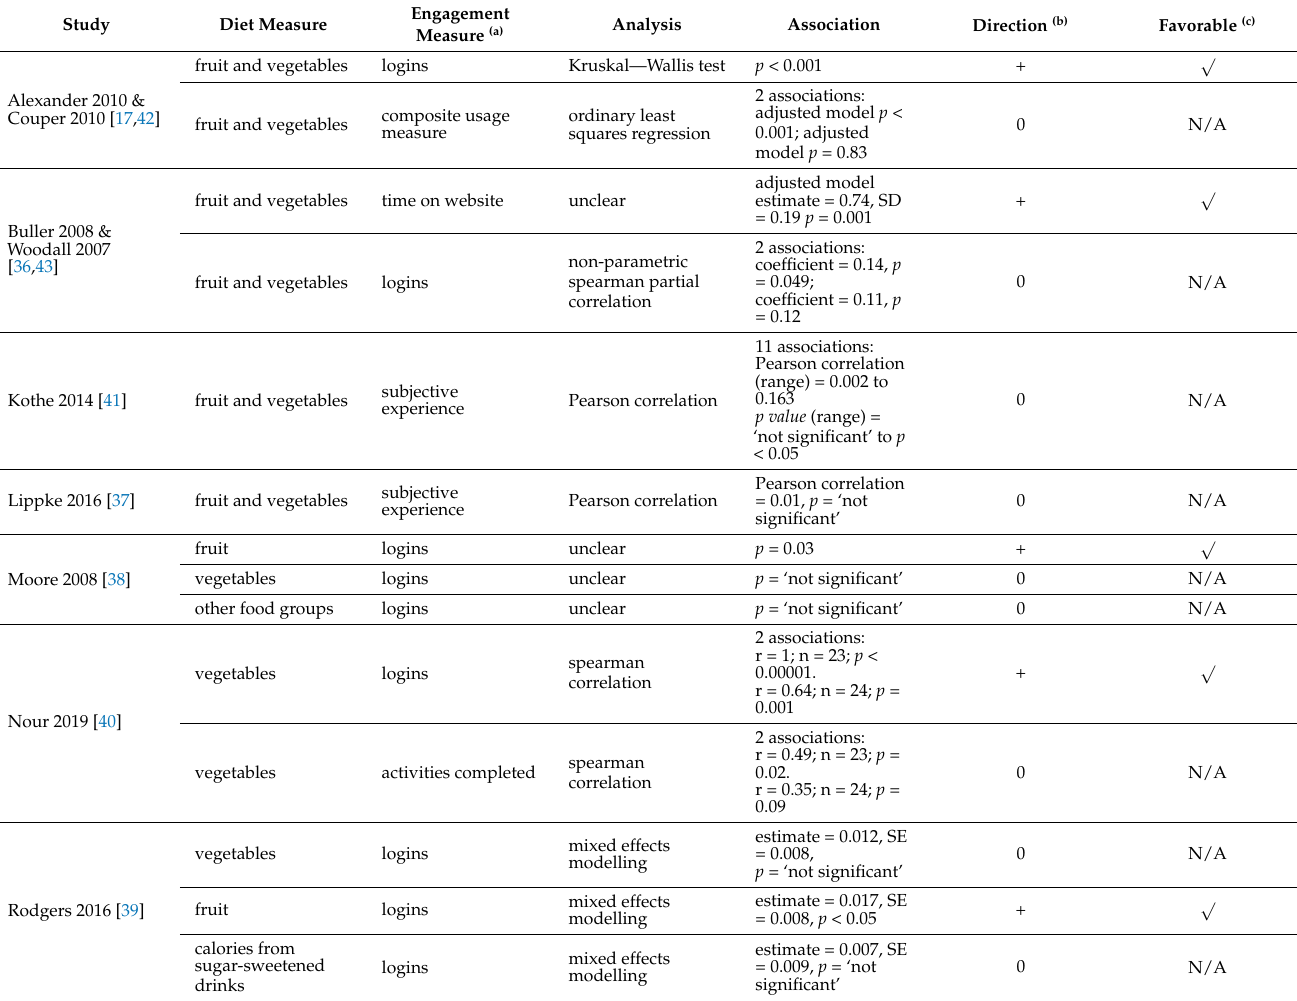
Table 4. Summary of associations included in the